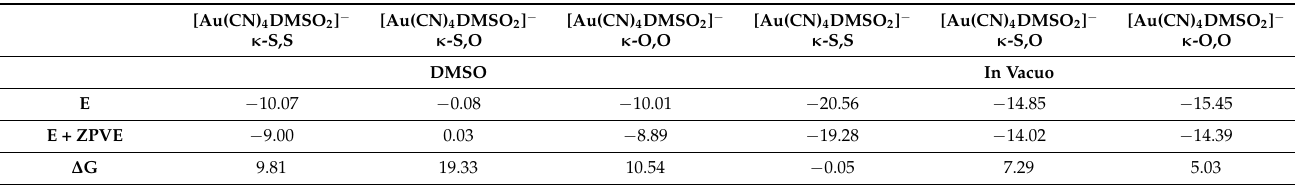
Table 6. Energy (E); energy corrected by the zero ‐ point vibrational energy (E + ZPVE); Gibbs free energy ( Δ G) of the complex formation of gold(III) tricyanide aquo complex. In vacuo—results obtained without solvation. Water—results obtained using PCM implicit solvation model. All values are in kcal/mol.